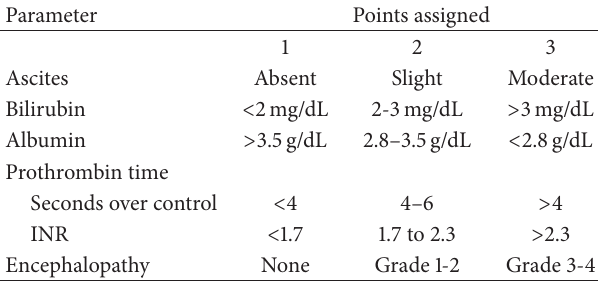
Table 1: Child-Turcotte-Pugh classification of severity of